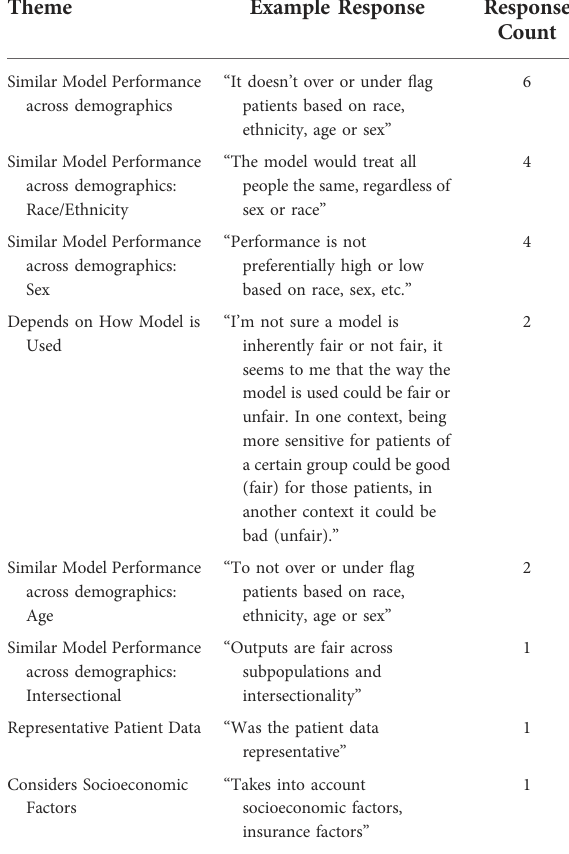
TABLE 11 Survey responses to “ what does it mean to you for a model to be fair? ”